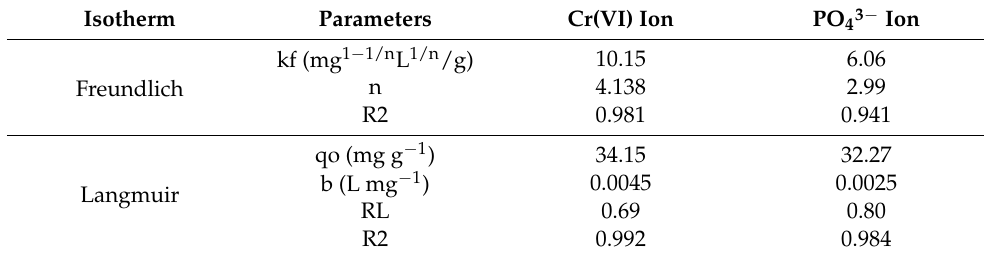
Figure 7. Freundlich and Langmuir isotherm models for ( a , c ) Cr(VI) and ( b , d ) PO 43 − . Table 1. Adsorption isotherm model parameters.